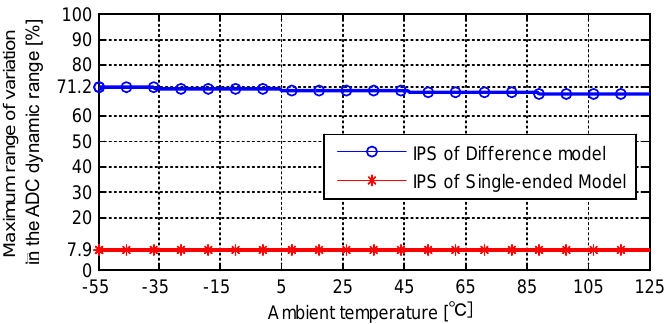
Figure 11. Maximum variation range in the analog − digital converter (ADC) dynamic range. Table 2. Comparison of measurement sensitivities. IPS—inductive proximity sensor; LSB—least significant bit.